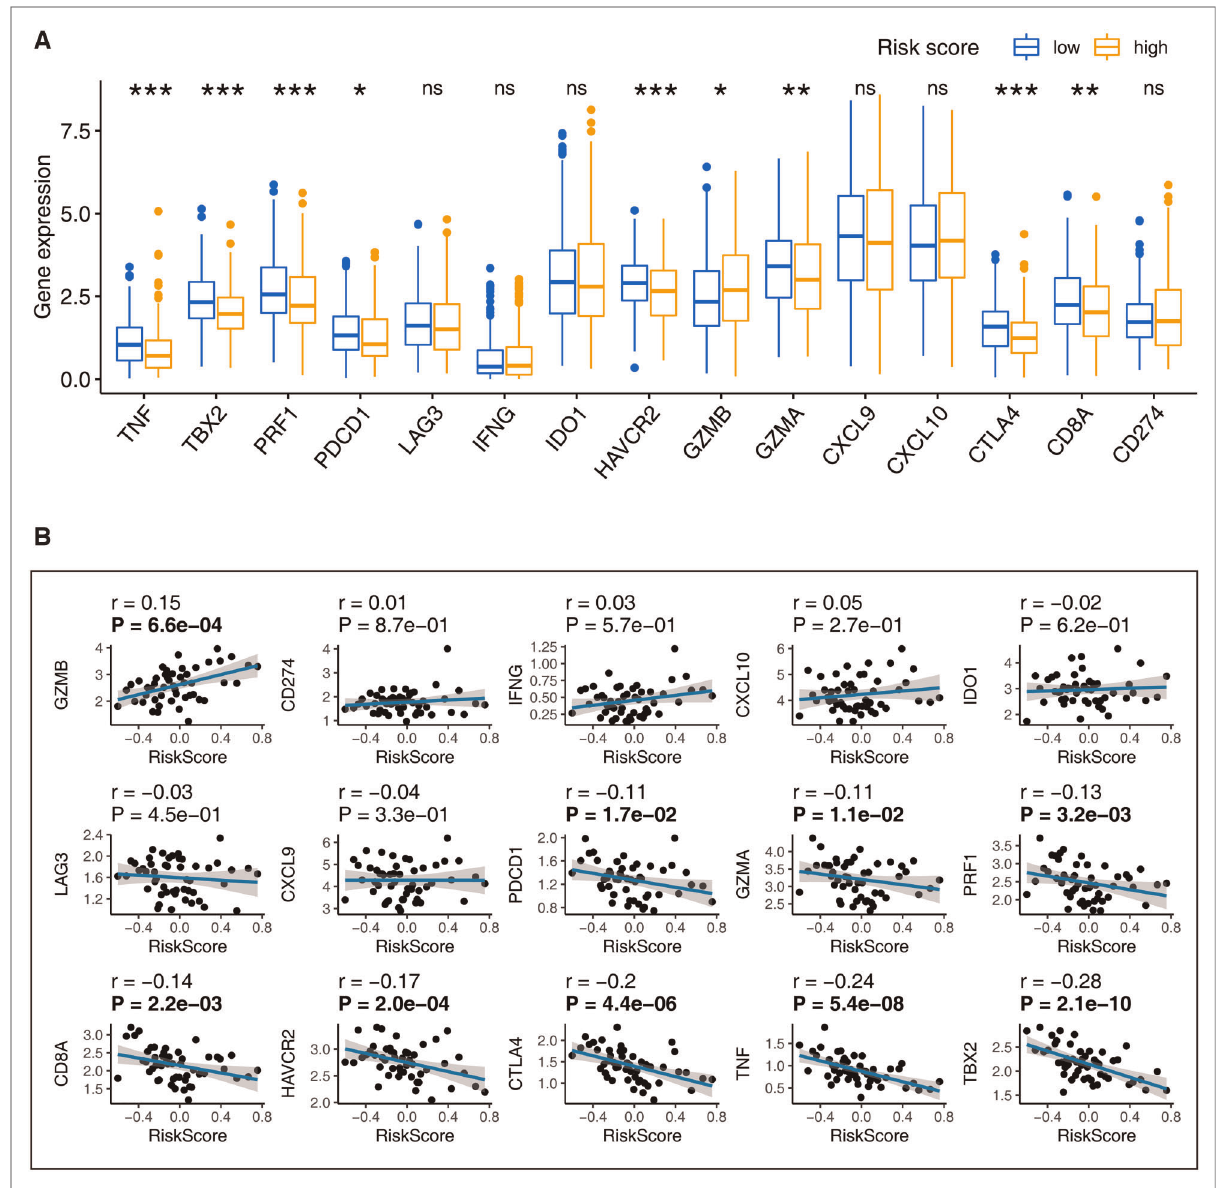
FIGURE 6 Determination of the immune relevant signatures that are signi fi cantly related to our signature. ( A ) LUADs were grouped into low- and high-risk based on their median risk score. The Wilcoxon rank-sum found immune signatures that differentially distributed in the high-risk and low-risk patients. ( B ) The Spearman ’ s coef fi cient evaluated the correlations between our signature and immune relevant signatures. ns: p -value>0.05; *: p -value<0.05; **: p -value<0.01; A p -value<0.05 means statistical signi fi cance; The bold p -value in plot B indicates that <0.05. LUAD, lung